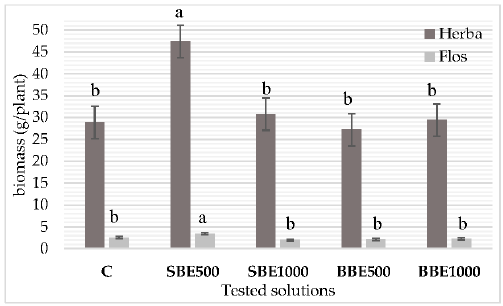
Figure 1. The influence of bark extracts on Lavandula angustifolia Mill. biomass accumulation. Error bars represent the standard deviations of means. C—Control, SBE500—spruce bark extract at 500 mg dry bark / 100 mL solvent, SBE1000—spruce bark extract at 1000 mg dry bark / 100 mL solvent,